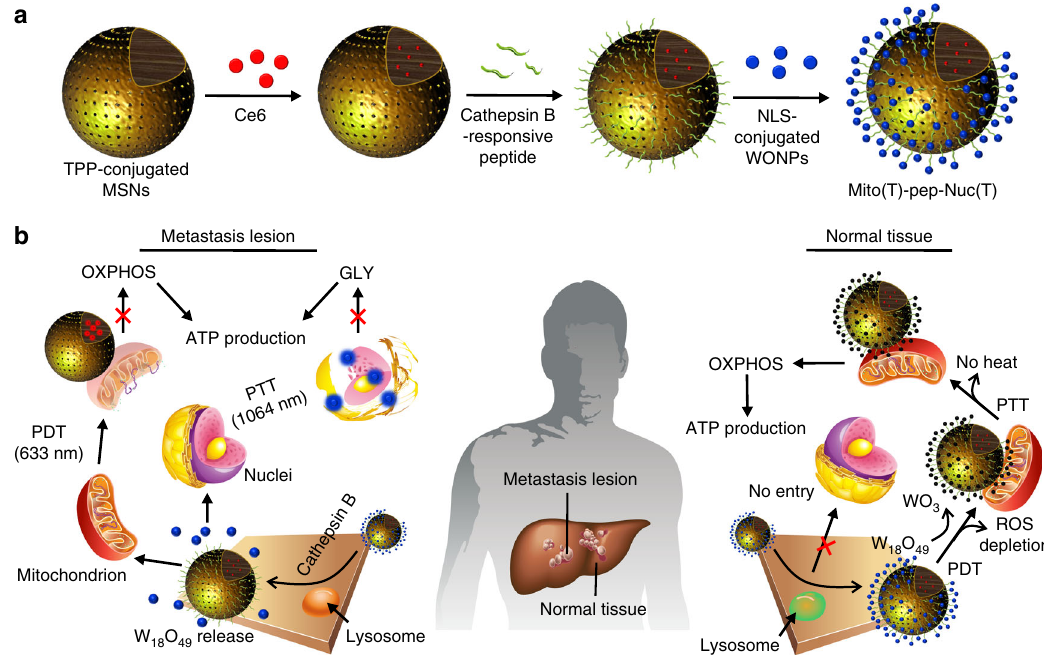
Fig. 1 Working principle of Mito(T)-pep-Nuc(T). a Synthetic procedure of the mitochondria and nucleus dual-targeting platform, Mito(T)-pep-Nuc(T). b A schematic illustration showing the mechanism that synthesized nanomedicine could distinguish metastasis lesions from normal liver parenchyma. In cancer cells metastasized to the liver, the internalized Mito(T)-pep-Nuc(T) will be destabilized upon the cleavage mediated by the overexpressed Cathepsin B enzyme. The released MSNs and W 18 O 49 NPs will then respectively target mitochondria and nucleus, consequently leading to their impairment upon laser irradiation (633 nm followed by 1064 nm in order to trigger PDT and PTT, respectively). In hepatocytes, the internalized Mito(T)- pep-Nuc(T) remains morphologically intact. Upon the irradiation with 633-nm laser, the consumption of singlet oxygen by WONPs could result in their oxidation into WO 3 featuring attenuated heating power upon subsequent laser irradiation (1064 nm). On this basis, hepatocytes and metastasis cancer cells are being treated differently, leaving only the latter one be ablated. TPP triphenyl phosphonium, WONPs W 18 O 49 nanoparticles, OXPHOS oxidative phosphorylation, GLY glycolysis, PDT, photodynamic therapy, PTT photothermal